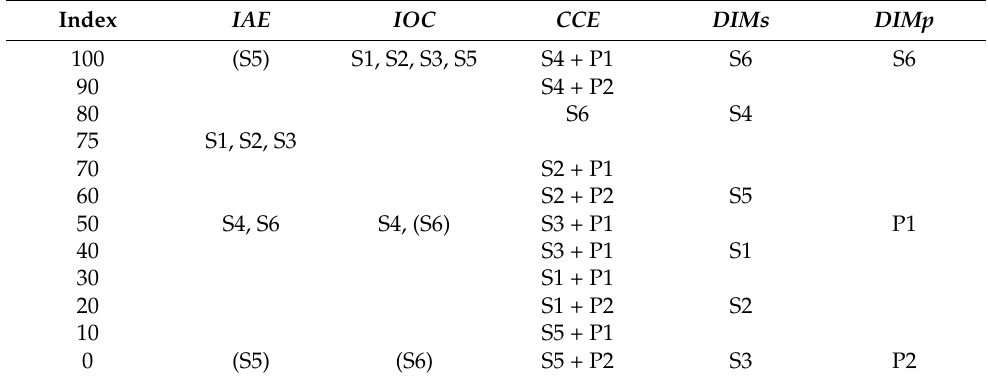
Table 5. Rating criterion of five non-computable